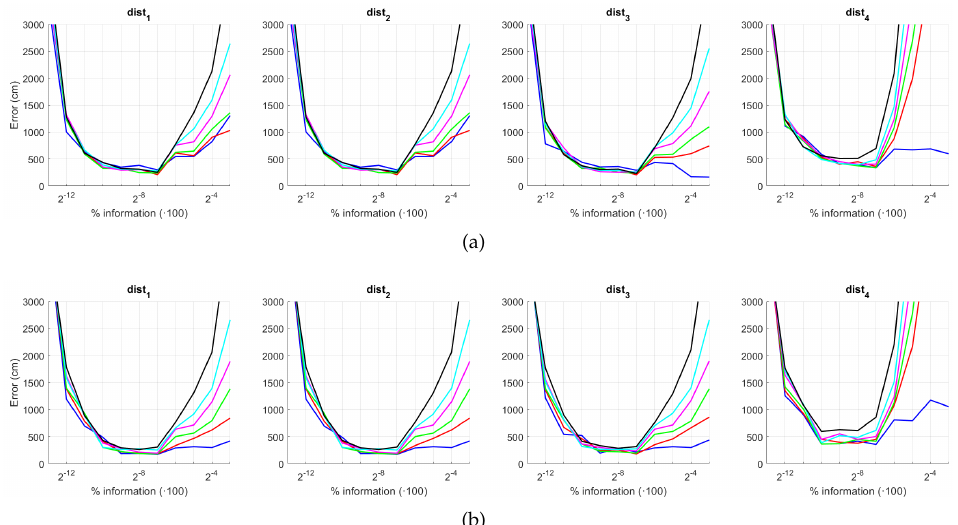
Figure 28. BG average localization error with noise: ( a ) no filter and ( b ) homomorphic filtering. Legend: —– Original, —– Noise 1, —– Noise 2, —– Noise 3, —– Noise 4, —– Noise